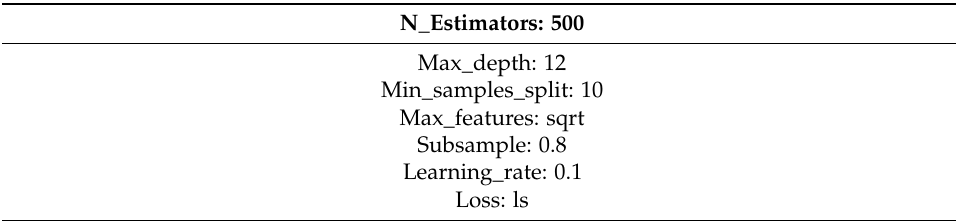
Table 6. GBR model parameters.